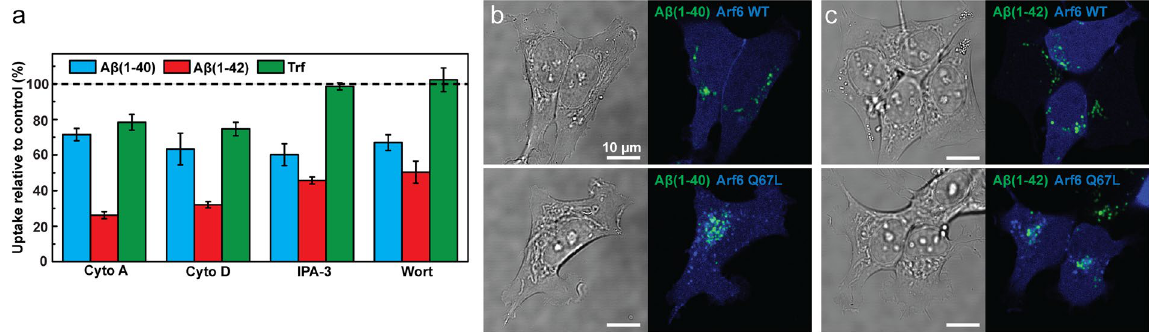
Figure 5. Uptake of A β (1–40), A β (1–42) and Trf in SH-SY5Y cells under conditions that perturb actin dependent endocytosis, macropinocytosis and Arf6-dependent endocytosis. ( a ) Uptake of HF488-labelled A β (1–40), A β (1–42) and AF647-labelled Trf in cells treated with 10 µ M cytochalasin A (cyto A) and 25 µ g/ml cytochalasin D (cyto D) to perturb actin polymerisation, or 10 µ M IPA-3 and 25 nM wortmannin (wort) to perturb macropinocytosis. The peptide uptake is reported as mean cellular uptake relative to control (cells not treated with inhibitor) calculated based on mean cellular fluorescence intensity ± SD of the total number of gated live cells for three replicate samples (n = 3) measured by flow cytometry and corrected for baseline contributions by subtracting the cellular autofluorescence. ( b , c ) Images showing uptake of HF488-labelled A β (1–40) ( b ) and A β (1–42) ( c ) (green) in cells transfected with BFP-labelled Arf6 WT or Q67L (blue) alongside transmitted images showing the cells. The cells were incubated with A β 24 h post transfection. The A β concentration was 1 μ M and the concentration of Trf was 5 µ g/ml in all experiments. Cells were incubated with A β for 1 h (flow cytometry) or 24 h (confocal microscopy), and Trf for 5